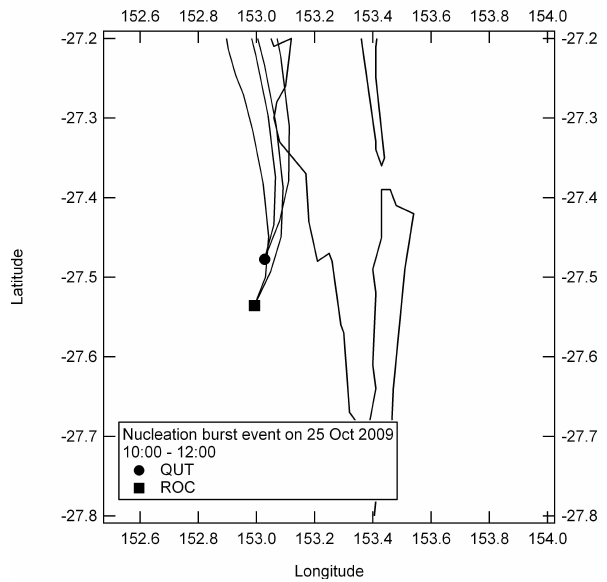
Fig. 8. Back-trajectories calculated for the burst events on 25 Oct